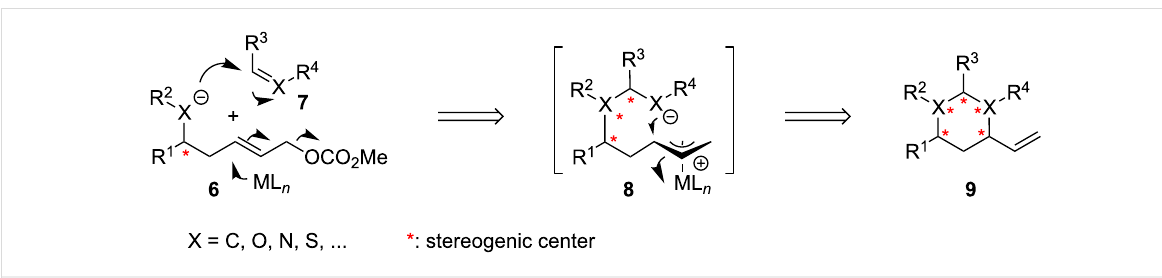
Scheme 1: General concept for heterocycles synthesis based on a nucleophilic addition and Tsuji–Trost